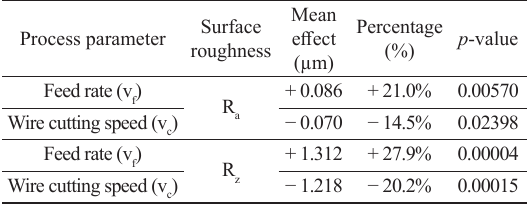
Table 3. ANOVA results for surface roughness parameters (R Process